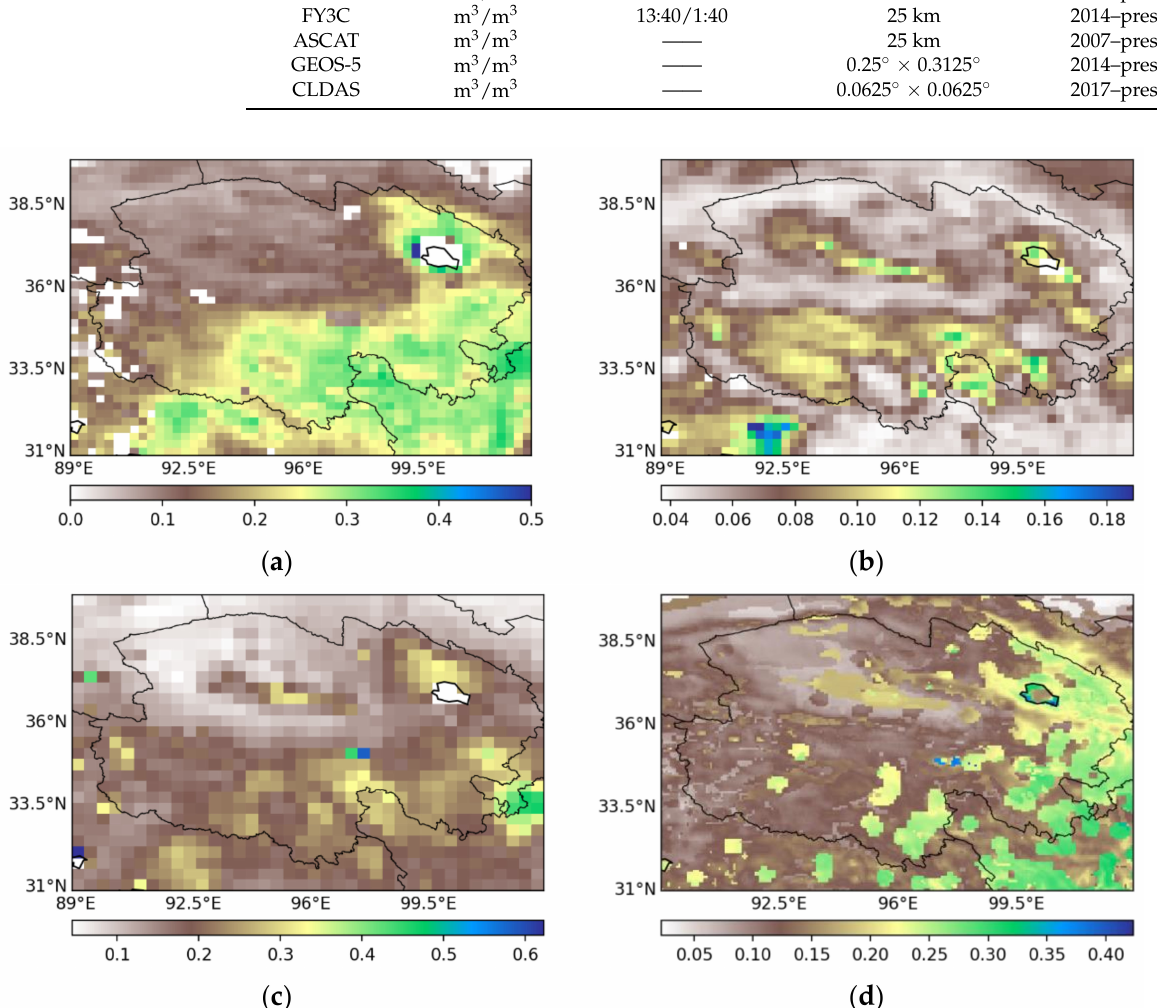
Figure 1. Daily average soil-moisture maps from ( a ) FY3C; ( b ) AMSR2; ( c ) SMAP; ( d )